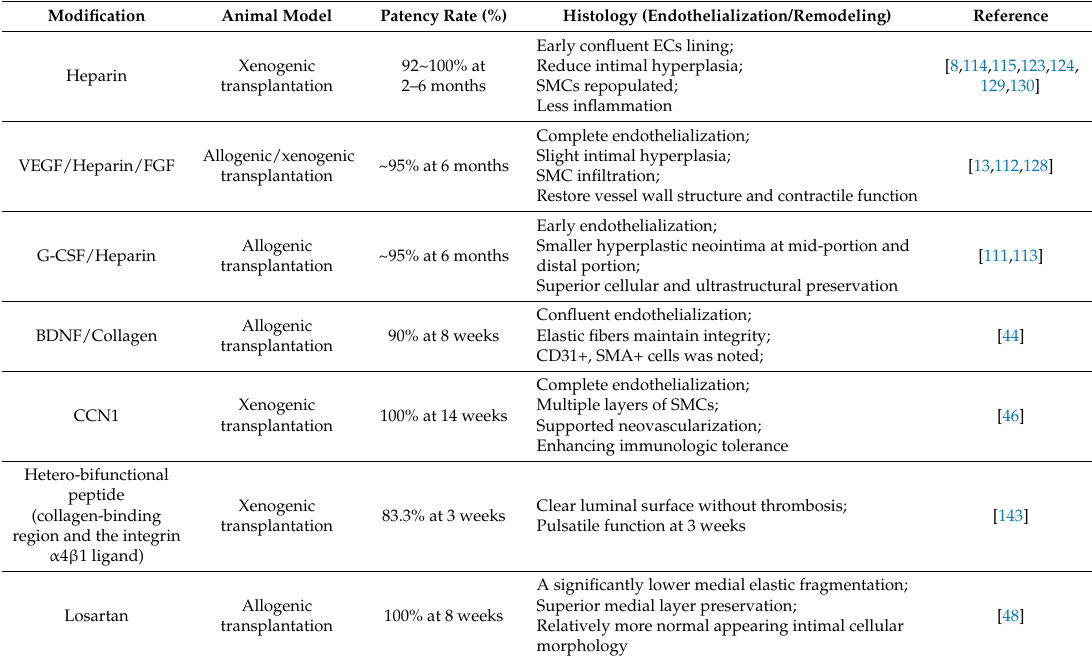
Table 3. Summary of in vivo performance of biomolecule/growth factor-modified decellularized vascular grafts since